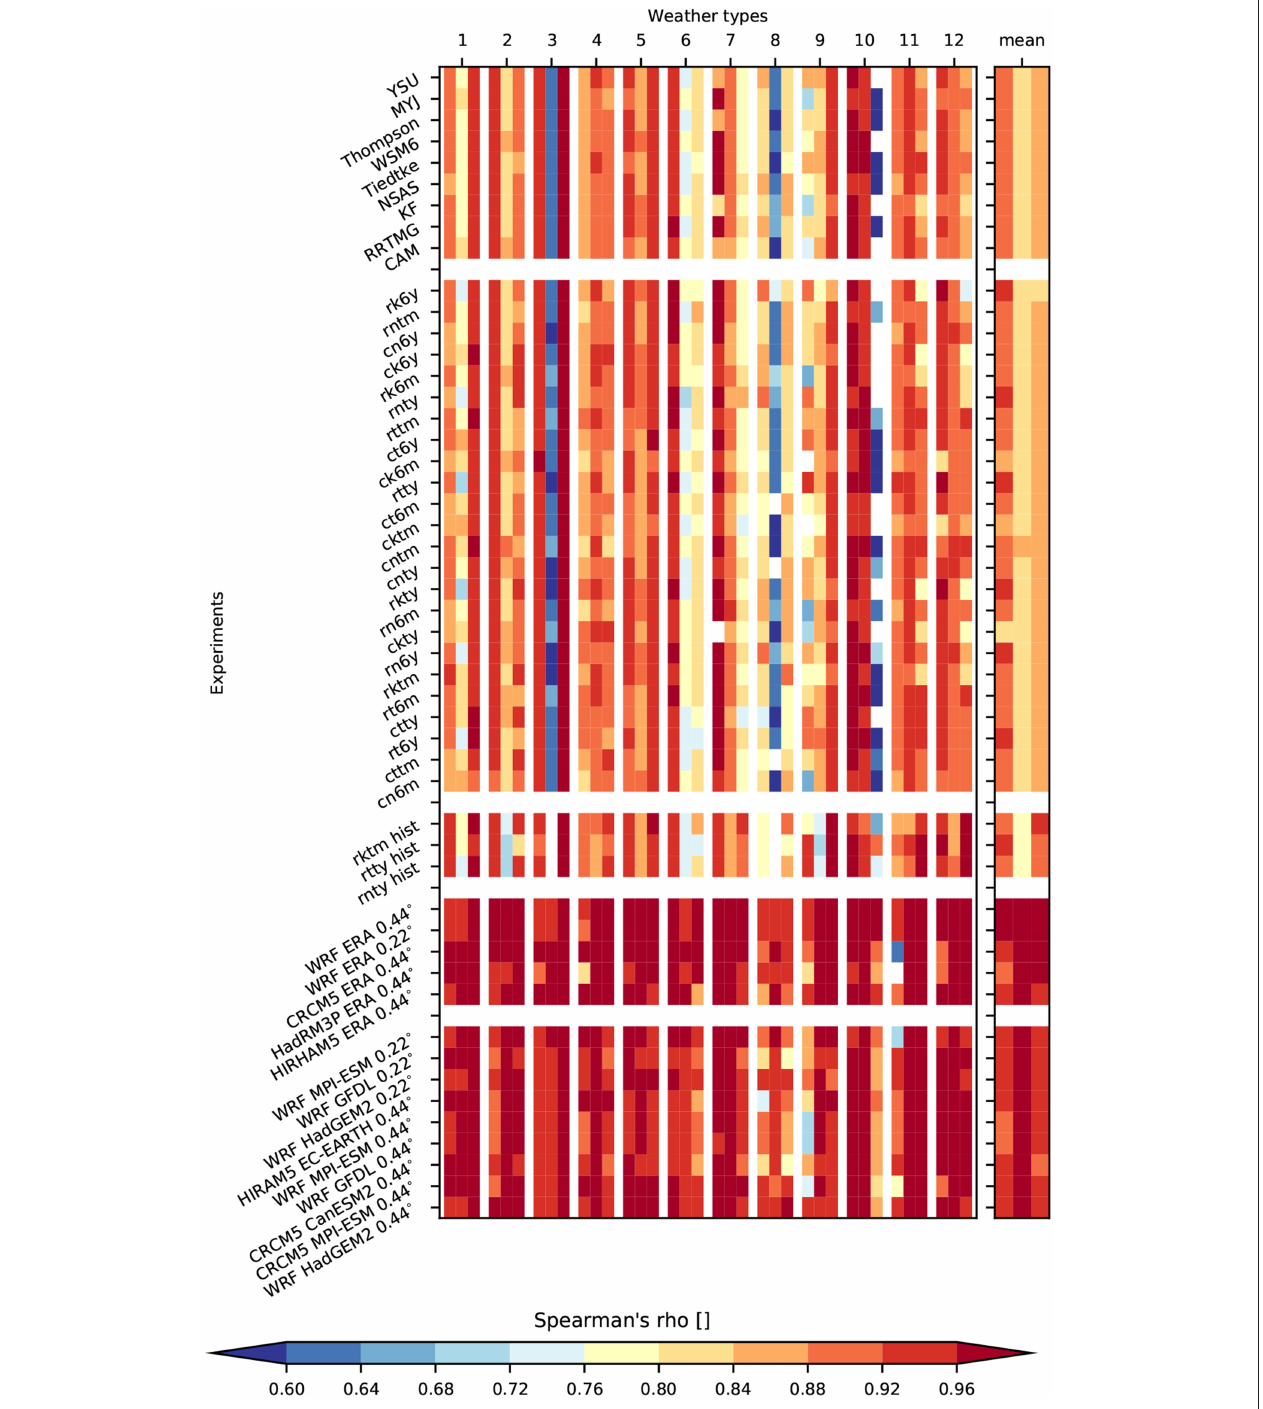
FIGURE 8 | Similar to Figure 6 but showing correlation coefficients between ERA-Interim and simulated centroids (higher is better). Each column consists of three sub-columns showing correlation coefficients for SLP, PW, and 500 UV from left to right.